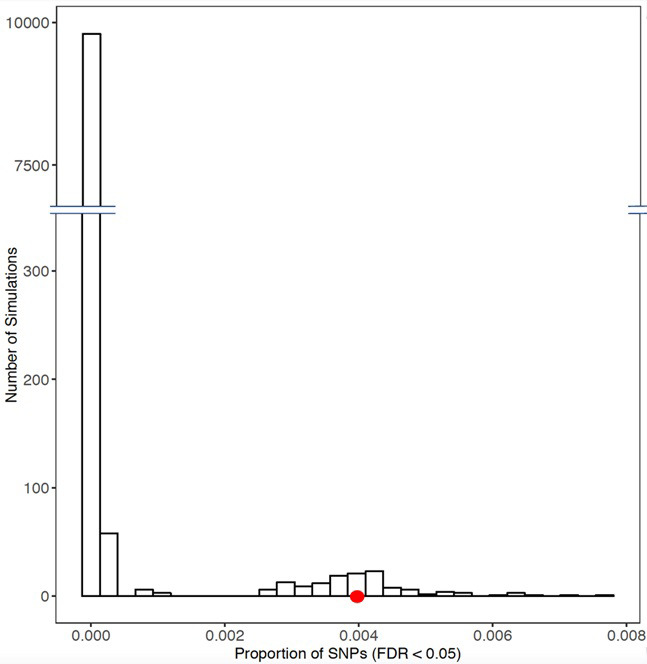
Histogram of frequency in which permutations of eSNPs generated from random sets of 103 genes revealed similar p-values to those generated from the set of 103 differential response genes to glucose (red dot).For each resampling, 103 genes were chosen at random from the genome. eSNPs for each gene were generated from GTEx (version 7) using all 48 tissues. p-Values for each eSNP were determined in our prior meta-GWAS for diabetic retinopathy (Grassi et al., 2011). The x-axis shows the proportion of eSNPs in each set with an FDR < 0.05 in the diabetic retinopathy meta-GWAS. The figure reveals a significant shift to the right (represented by the red dot) for the glucose response gene eSNPs in the meta-GWAS compared to resampled eSNPs. Source and code files for this plot are available in Figure 3—source data 3, and additional source data files available at https://doi.org/10.5061/dryad.zkh18938j, and Source code 10.